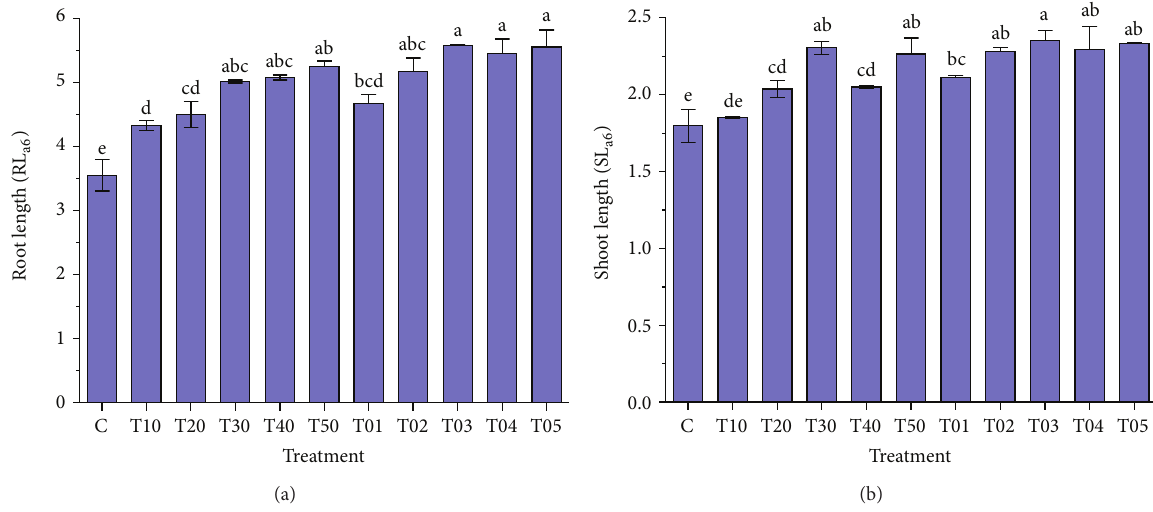
Figure 4: The effect of different periods of microwave frequency on shoot and root length in MR 219 rice variety. (a) Root length after six days and (b) shoot length after six days. Mean values ± SE are from three independent replicates, and values superscripted by different letters are significantly different by Duncan’s multiple range test ( 𝑃 ≤ 0.01 ). The treatments were (C) control, (T10) the first day, (T20) the first two days, (T30) the first three days, (T40) the first four days, (T50) the first five days, (T01) the first last day, (T02) the first two days, (T03)